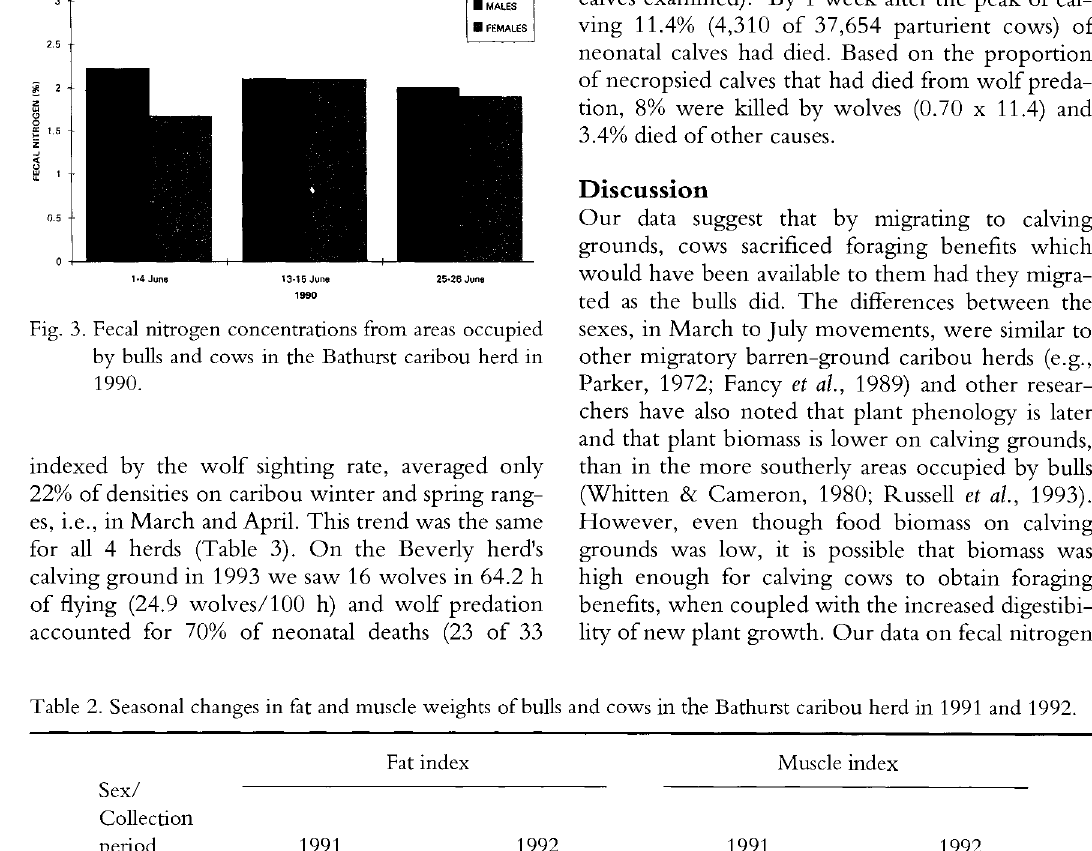
Table 3. The number of wolves seen per 100 hours when flying over caribou in March and April and on the calving grounds during calving in June (number of years of data; number of flying hours).